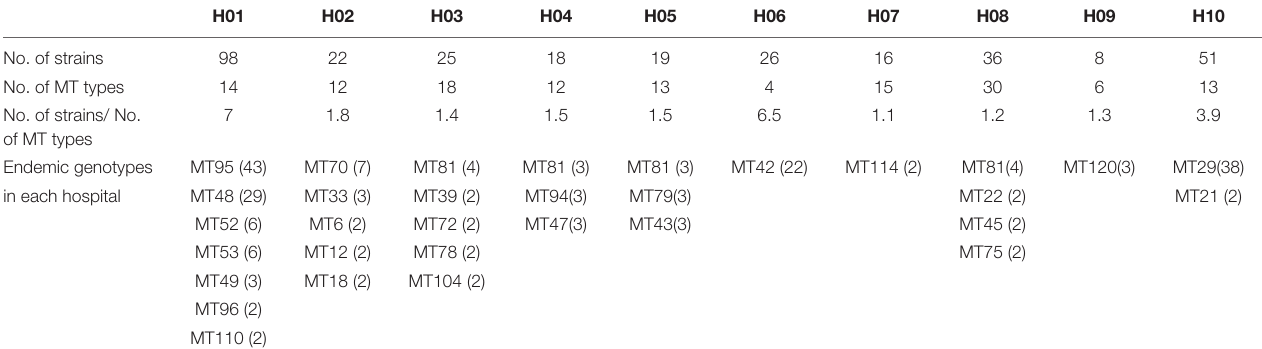
TABLE 3 | Distribution of 122 MT types in 10 hospitals.